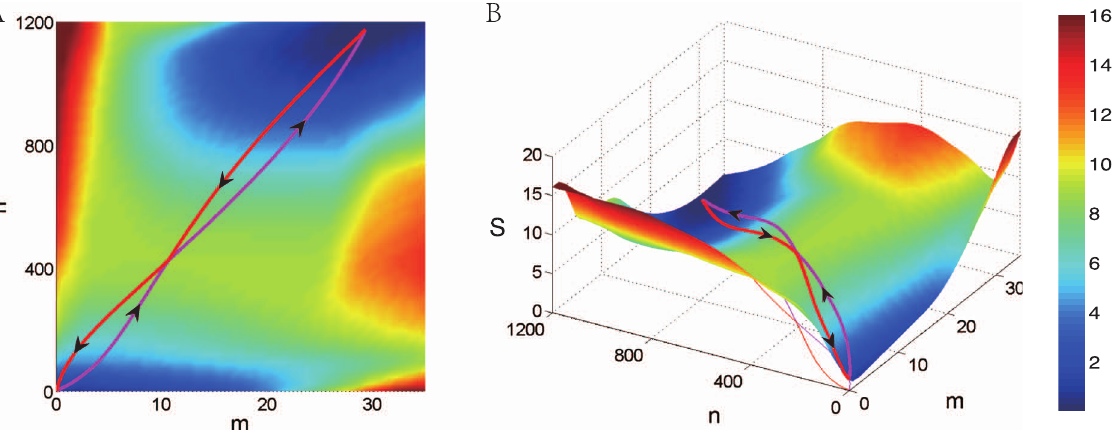
Figure 3. Quasipotential energy landscape of the whole genetic switching system with (A) two and (B) three dimensional view as well as switching paths between two stable fixed points. Each path passes through the saddle point. Here, the parameters are the same as in Fig. 2.